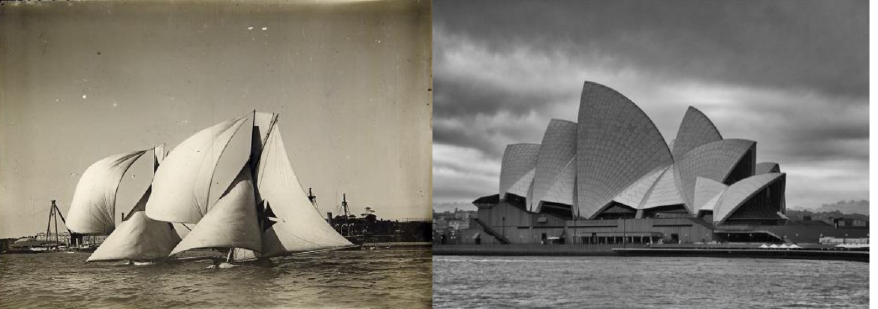
Figure 4. Left : boat with its sails unfurled (https://www.breizhskiff.com/tag/bethwaite/; last accessed 29 October 2021). Right : a hypothetical inspiration for Sydney Opera House (Photo by Douglas Banard; www.fineartamerica.com; last accessed 29 October